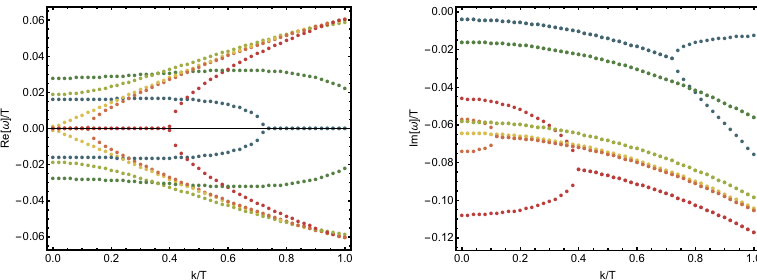
Figure 18 . The lowest modes in the transverse sector for m=T = 0 : 1 ; (cid:12) = 1 ; (cid:11) 2 f 0 : 001 ; 0 : 151 g (blue to red). At small EXB, i.e. small (cid:11) , a gapped phonon is present in the spectrum. Going